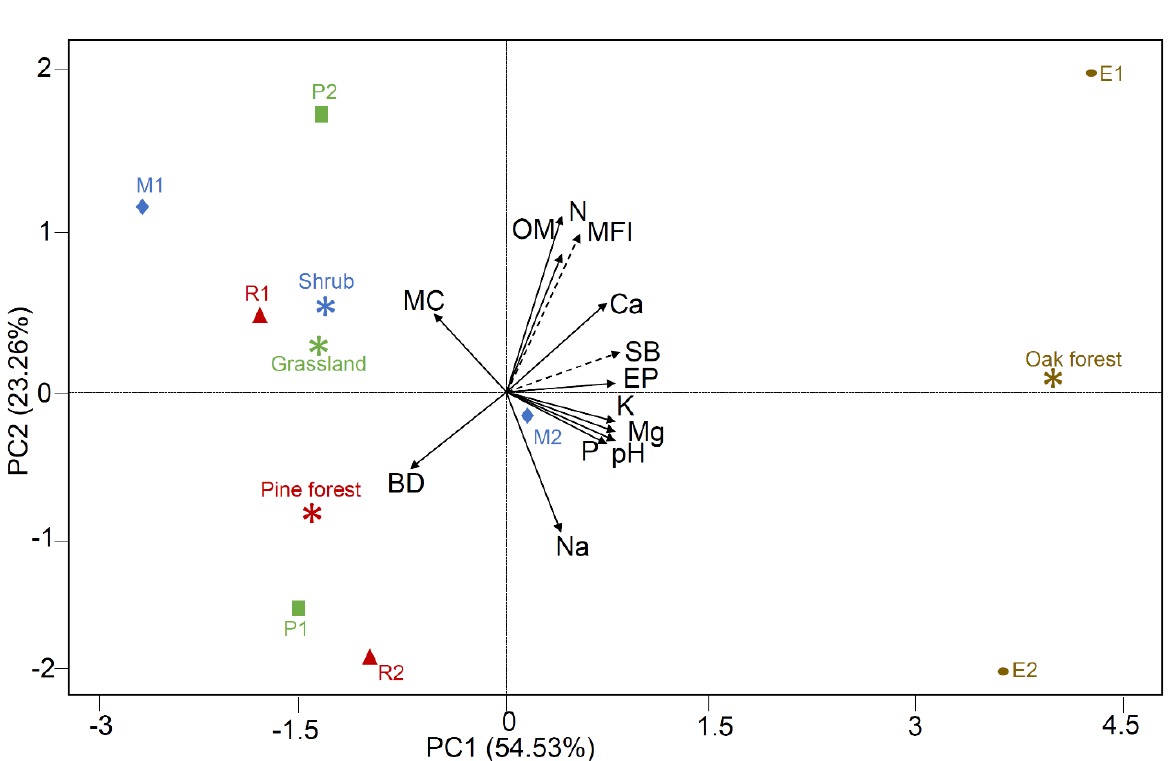
0.0024) and effective porosity (p-value < 0.0001) presented significant differences. The holm oak plots had the lowest bulk density and the highest porosity, with statistically significant differences compared with the other three types of vegetation. Pine afforesta- tion areas did not show significant differences in either variable, compared with shrubs and grasslands. Regarding the soil chemical properties, only K (p-value = 0.0052) and Mg (p-value = 0.0101) showed significant differences. In practice, oak forests presented the highest values of these nutrients, while pine afforestation areas did not present significant differences compared with shrubs and grasslands. In addition, organic matter, fertility, sum of bases, and contents of P, Ca, and N did not show statistically significant differences among these three land uses.